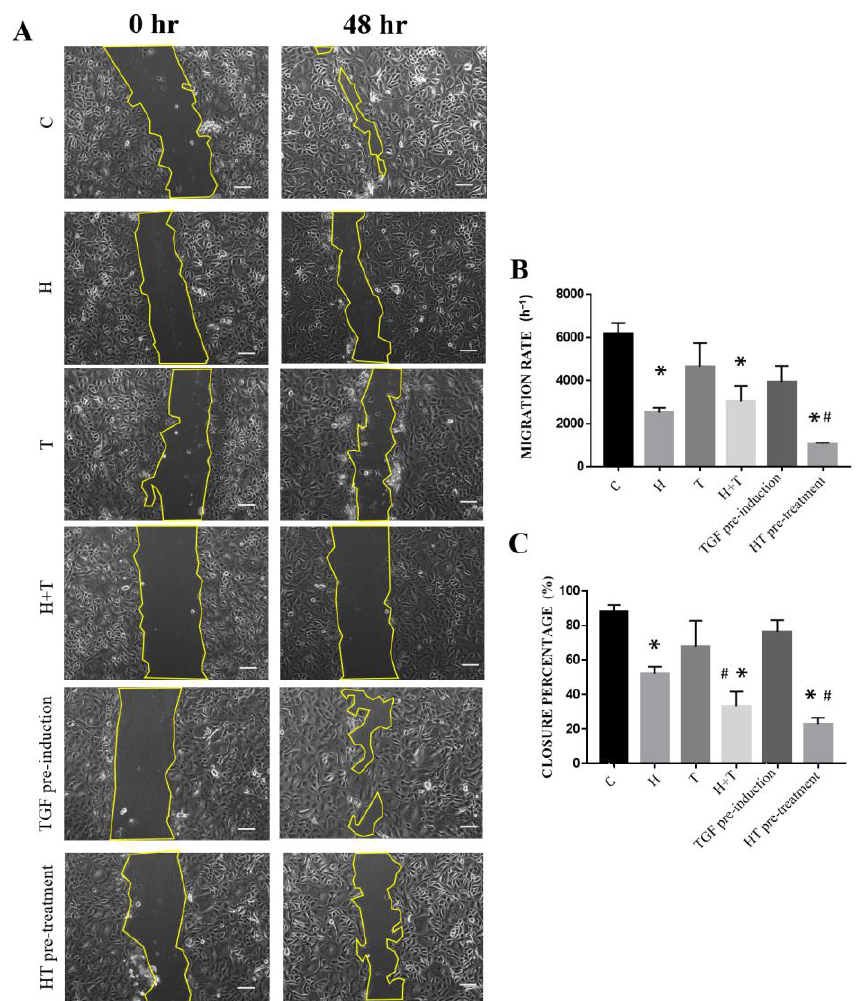
Figure 5. ( A ) Migration of RECs that had been cultured in six conditions. ( B ) Cell migration rate. ( C ) Scratch closure percentage. * p < 0.05: significantly different from control. # p < 0.05: significantly different from Group T (Supplementary Material Table S5). Scale bar represent 100 µm